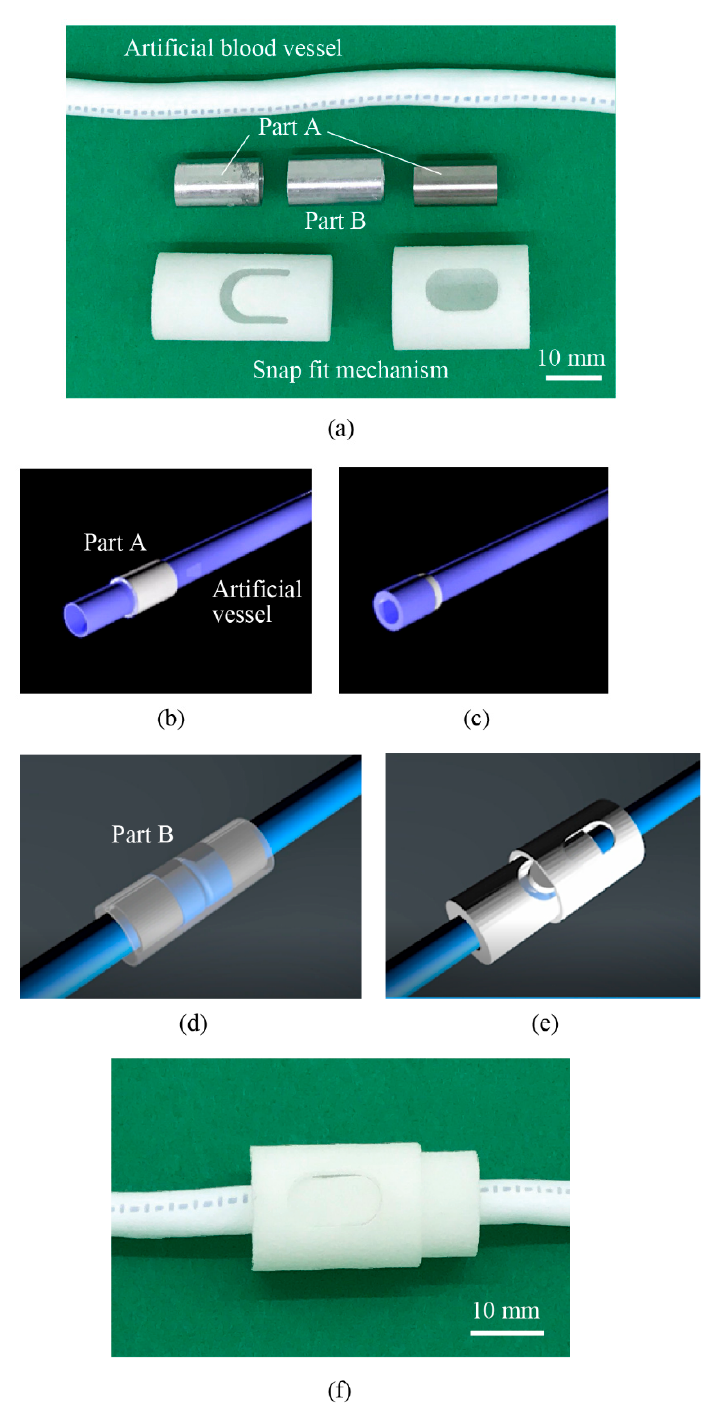
Figure 2. Proposed connecting mechanism of artificial blood vessels. ( a ) The mechanism consists of metal part A and B, 3D-printed snap fit mechanism, and artificial vessels. ( b , c ) The edges of the vessels to be joined are turned inside out over part A. ( d ) They are brought into contact inside part B. ( e ) The snap fit mechanism secures the connection. ( f ) The photo of the connected mechanism. The resulting size of the connection mechanism is 15.4 mm in diameter and 29.0 mm in length.